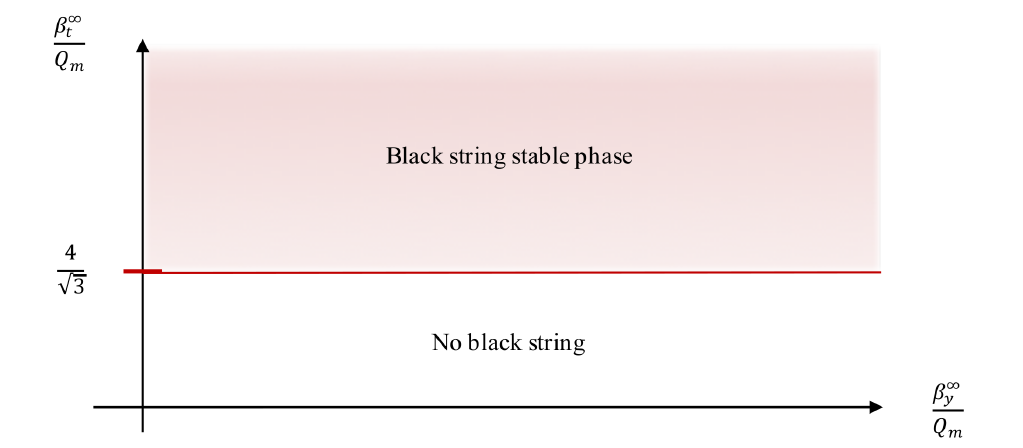
Figure 1 . Plots of I ∞ extrema (a), one extremum (b) and two extrema (c).